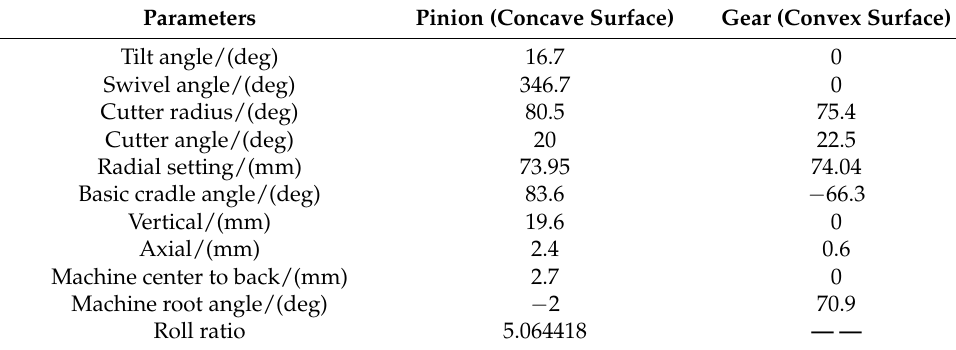
Table 2. Machining parameters for theoretical tooth surfaces.